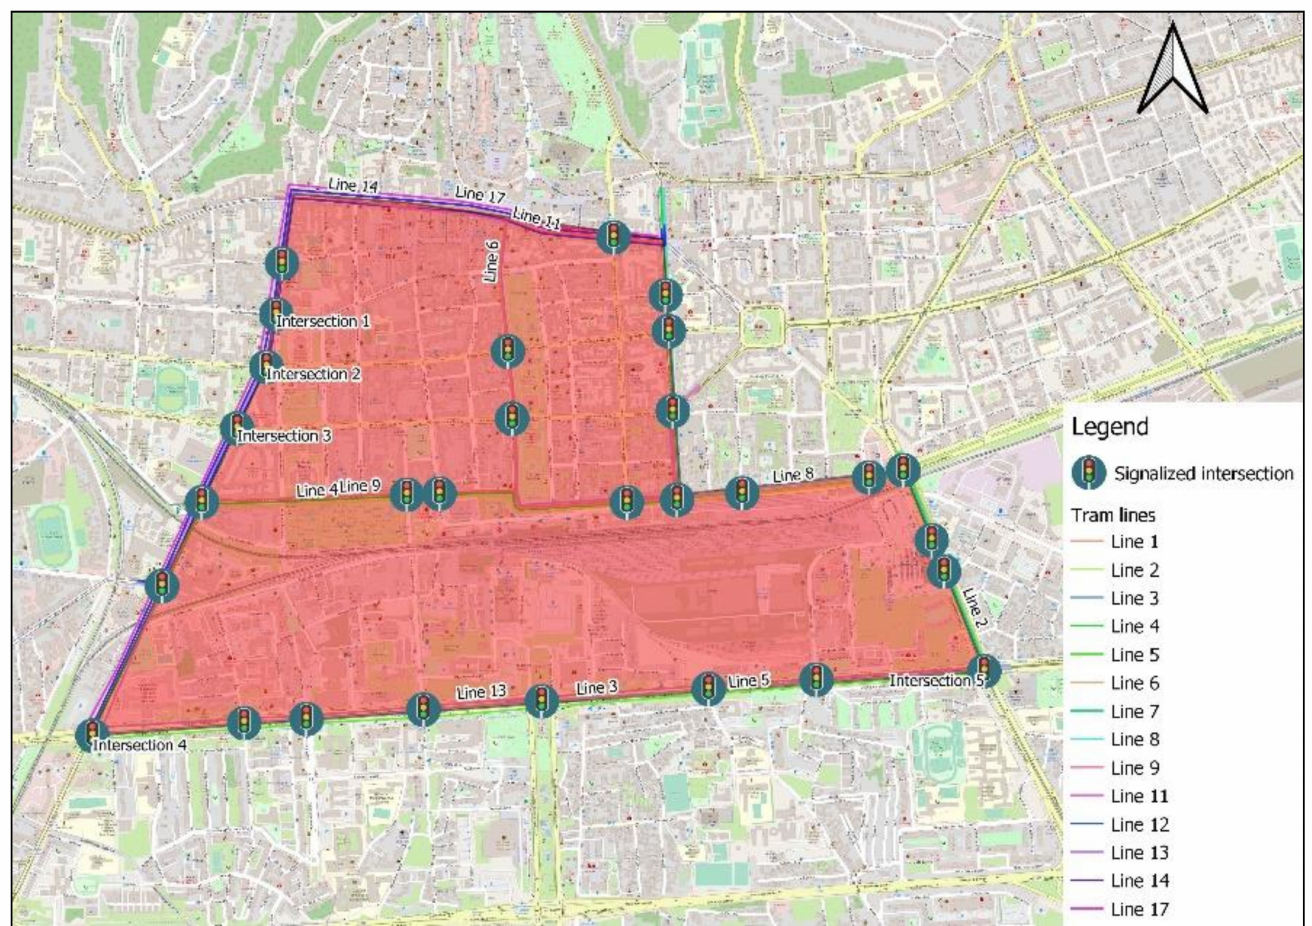
Figure 1. Study area in the center of City of